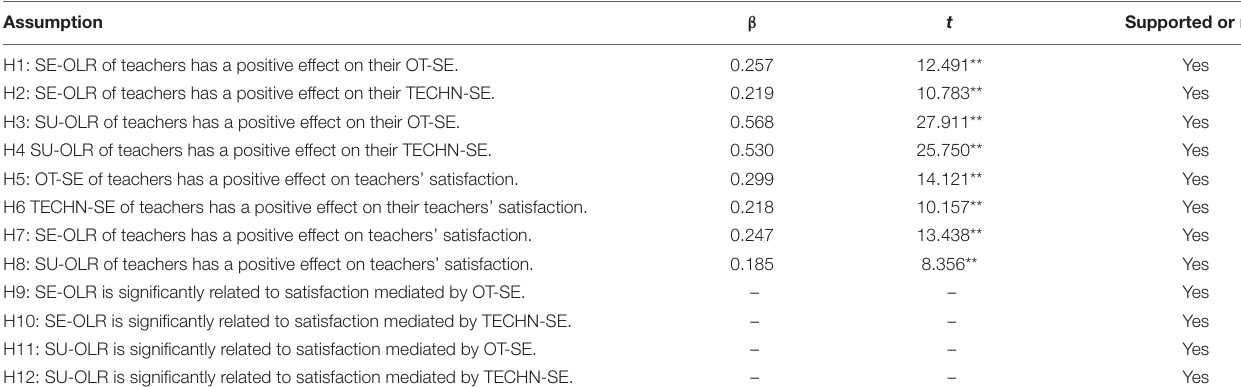
FIGURE 2 | Model results. ** indicates significance at p < 0.01. TABLE 7 | Hypothesis test analysis results.